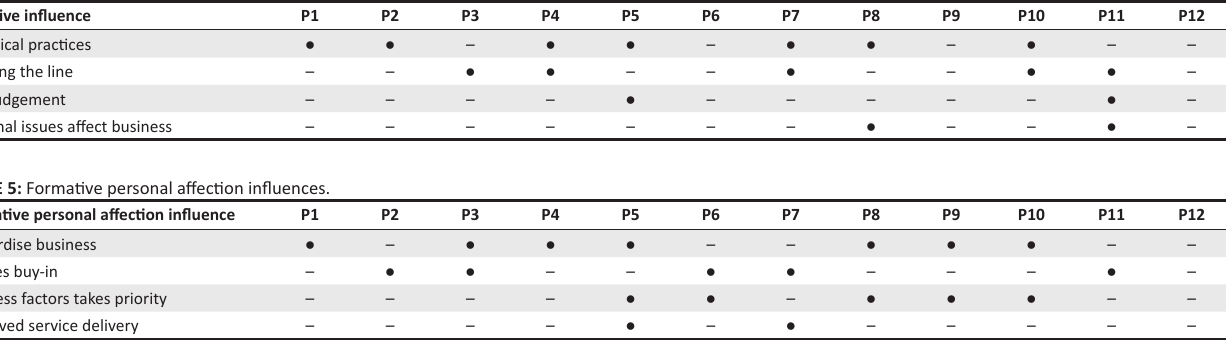
TABLE 4: Negative influences of interpersonal relationships on inter-organisational relationships. Negative influence